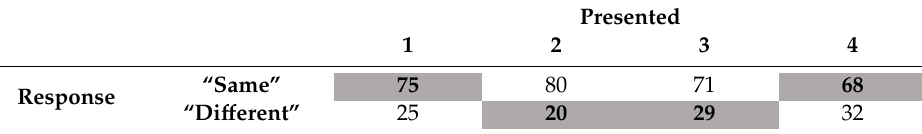
Table 2. The result of the first experiment.